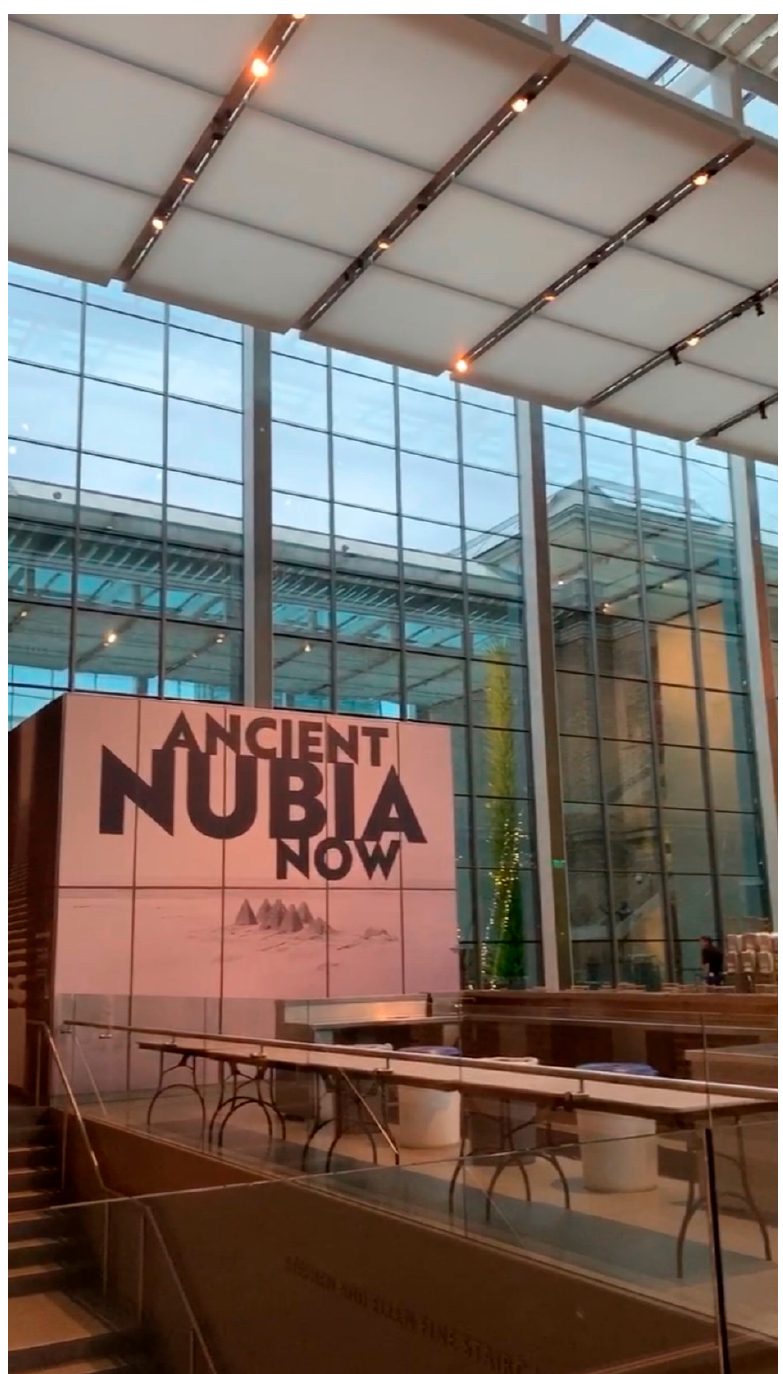
Figure 10. Ruth and Carl J. Shapiro Courtyard. Photo Source: Author.